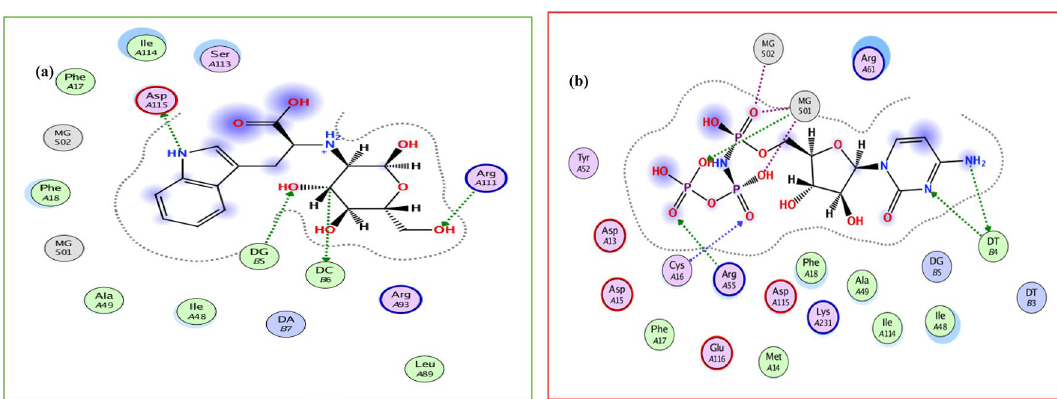
Figure 6. ( a ) The best pose of UNK4 in pocket site of receptors after 519 docking runs of Auto dock, ( b ) The best pose of